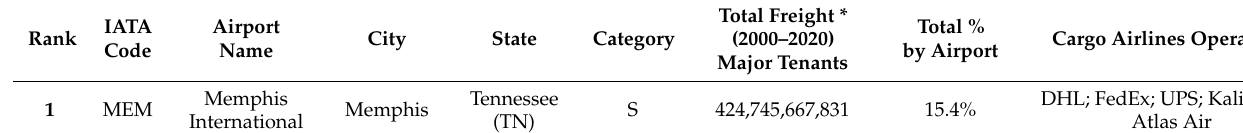
Table 2. Top 50 US cargo airports and cargo airline operations